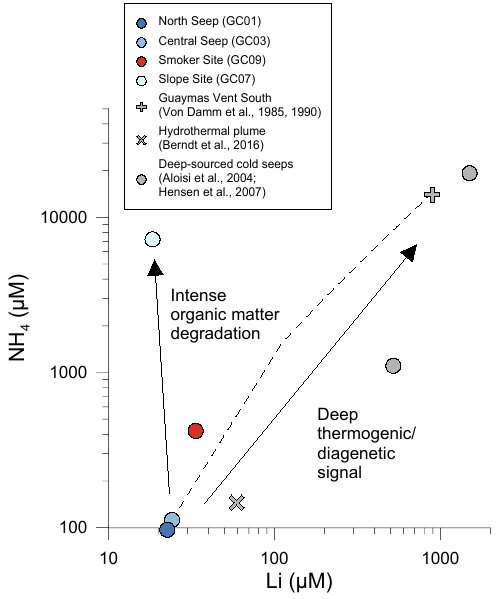
Figure 7. NH 4 (µM) versus Li concentrations (µM) of Guaymas Basin cold seeps (North, Central) and the Smoker Site. Deep fluids from the Smoker Site (GC09) mix with hydrothermal fluids with a share of ∼ 3%. The mixing line has been calculated as follows; x mix = x phase1 × f 1 + x phase2 × f 2 , (R1) with f 1 + f 2 = 1. Endmember 1 is the Guaymas Vent South (Von Damm, 1990; Von Damm et al., 1985) and endmember 2 is Guay- mas North Seep. For comparison, Guaymas hydrothermal endmem- ber fluid composition (Von Damm, 1990; Von Damm et al., 1985), hydrothermal plume fluid composition (Berndt et al., 2016), Guay- mas slope sediments (GC07), and deep-sourced cold seeps (Aloisi et al., 2004; Hensen et al., 2007) are shown.